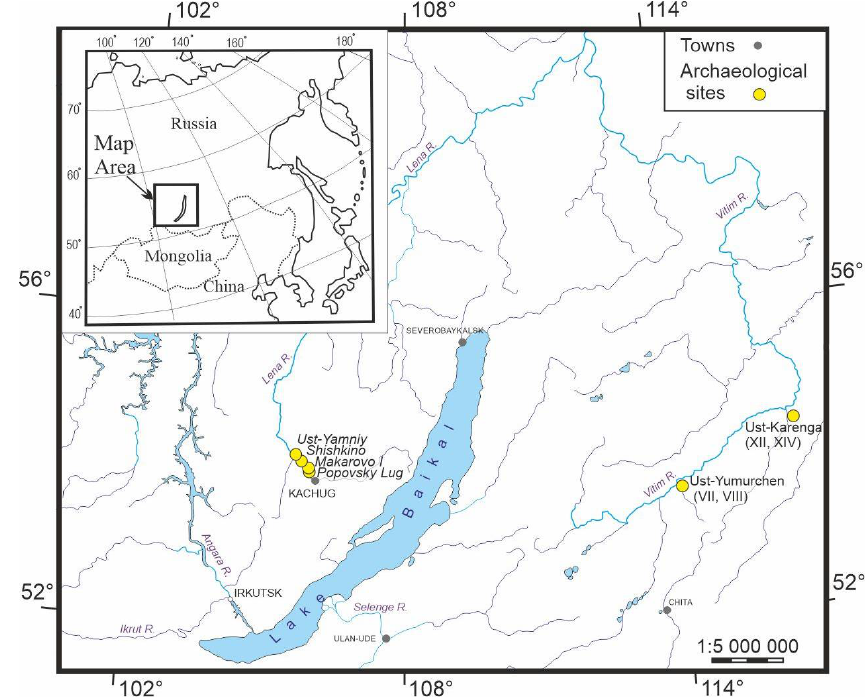
Figure 4. Map of archaeological sites.